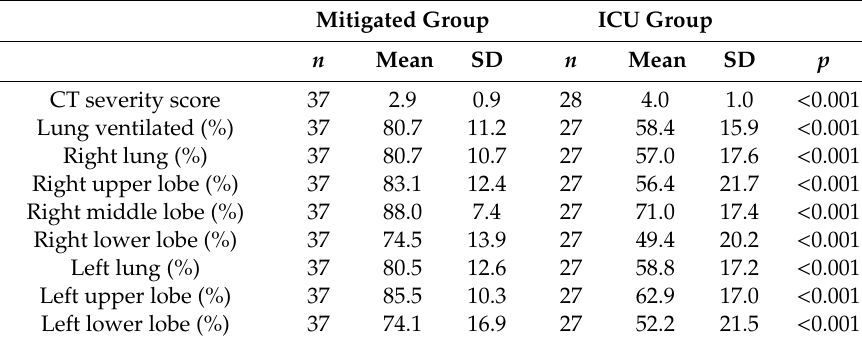
Table 2. Descriptive statistics of the imaging parameters. Parameters were compared between the two groups with student’s t test.